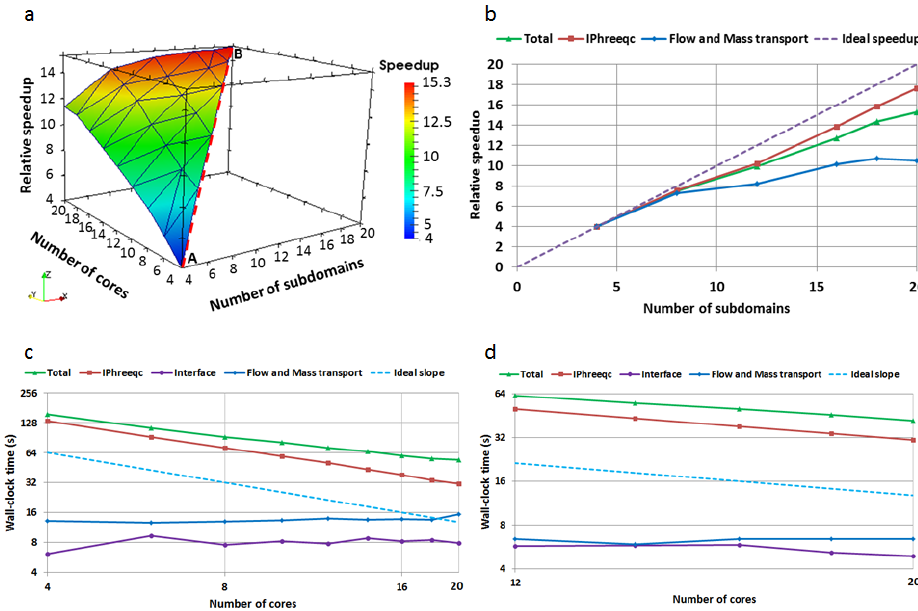
Figure 8. Performance of the proposed parallelization scheme in running isotope fractionation 2-D example on ENVINF. (a) Relationship between number of DDCs, number of compute cores and relative speedup in comparison to a simulation with four cores and four DDCs (color legend shows the value of relative speedup). (b) Breakdown of the speedup curve AB (marked as dashed line in a ) into speedup of calculation of chemical reaction, i.e., IPhreeqc and flow and mass transport. (c) Breakdown of the total time for chemical reactions, interface and flow and transport for DDC = 4. (d) Breakdown of the total time for DDC = 12.